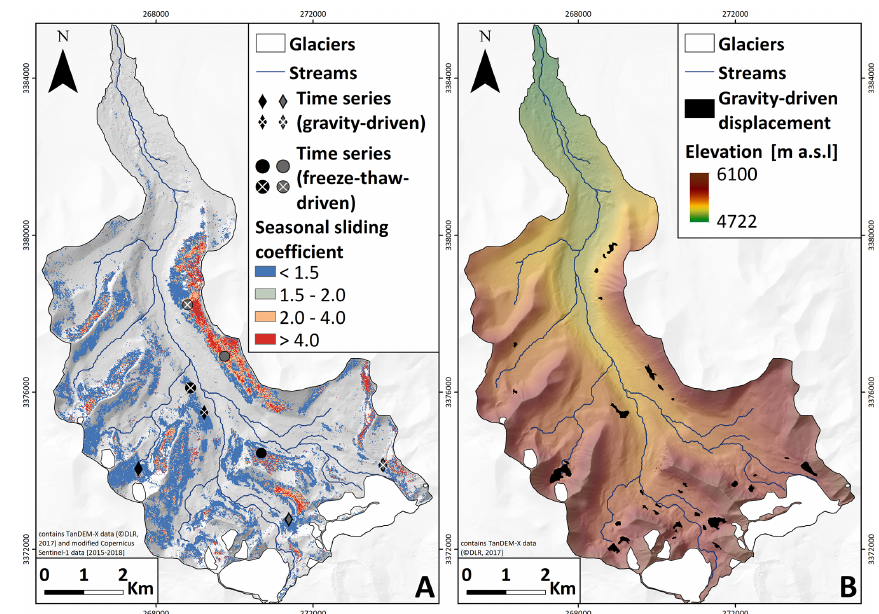
Figure 7. (a) SSM of the Qugaqie basin displaying the spatial distribution of slopes with accelerated surface velocity in summer compared to winter. A seasonal sliding coefficient of 1.5 represents a 50% increase in the velocity in summer. Only areas with a slope > 10 ◦ and a slope velocity > 10mmyr − 1 are shown. The locations of the time series in Fig. 6b, c are shown as rhombi/dots. (b) Spatial distribution of clusters where we assume displacement to be gravity-driven. These clusters display slope velocities > 50mmyr − 1 and a seasonal sliding coefficient <